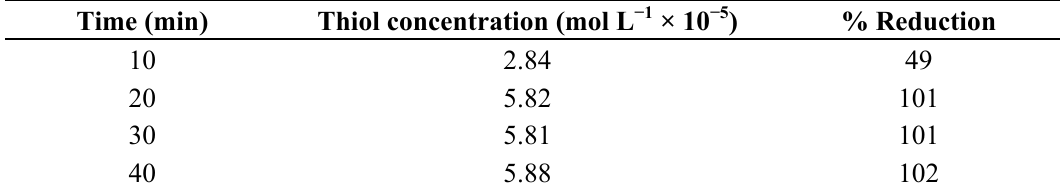
Table 2. Reduction of cystamine by zinc/acetic acid (mean, n = 3).